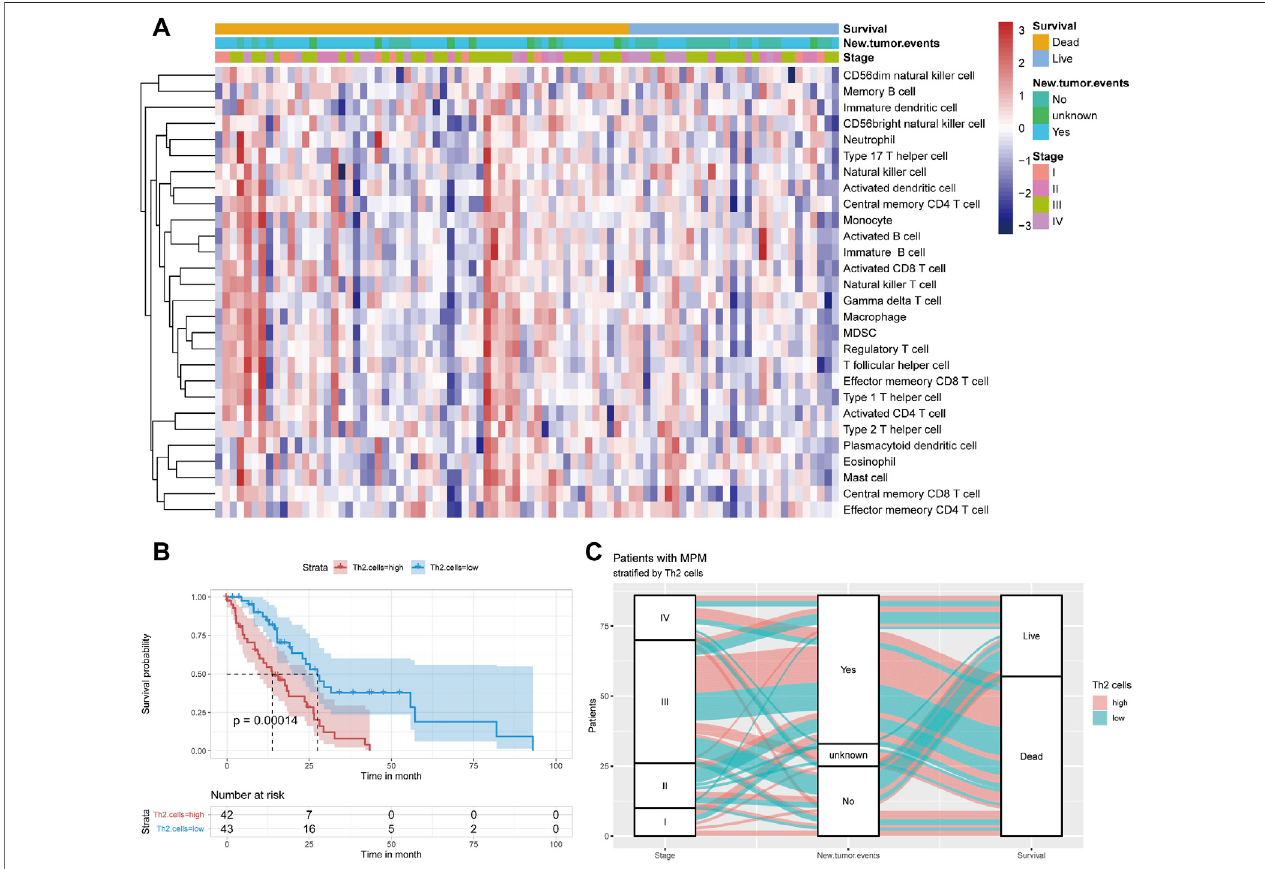
FIGURE2|(A) Immunocytein fi ltrationlevelsof85samplesfromTCGA. (B) Kaplan – MeiercurveofpatientsfromTCGAwhenusingthemedianofTh2cellin fi ltration levels as the cut-off value (C) Sankey plot depicting the relationship across the tumor stage, new tumor event and survival status of patients strati fi ed by median value of Th2 cell in fi ltration